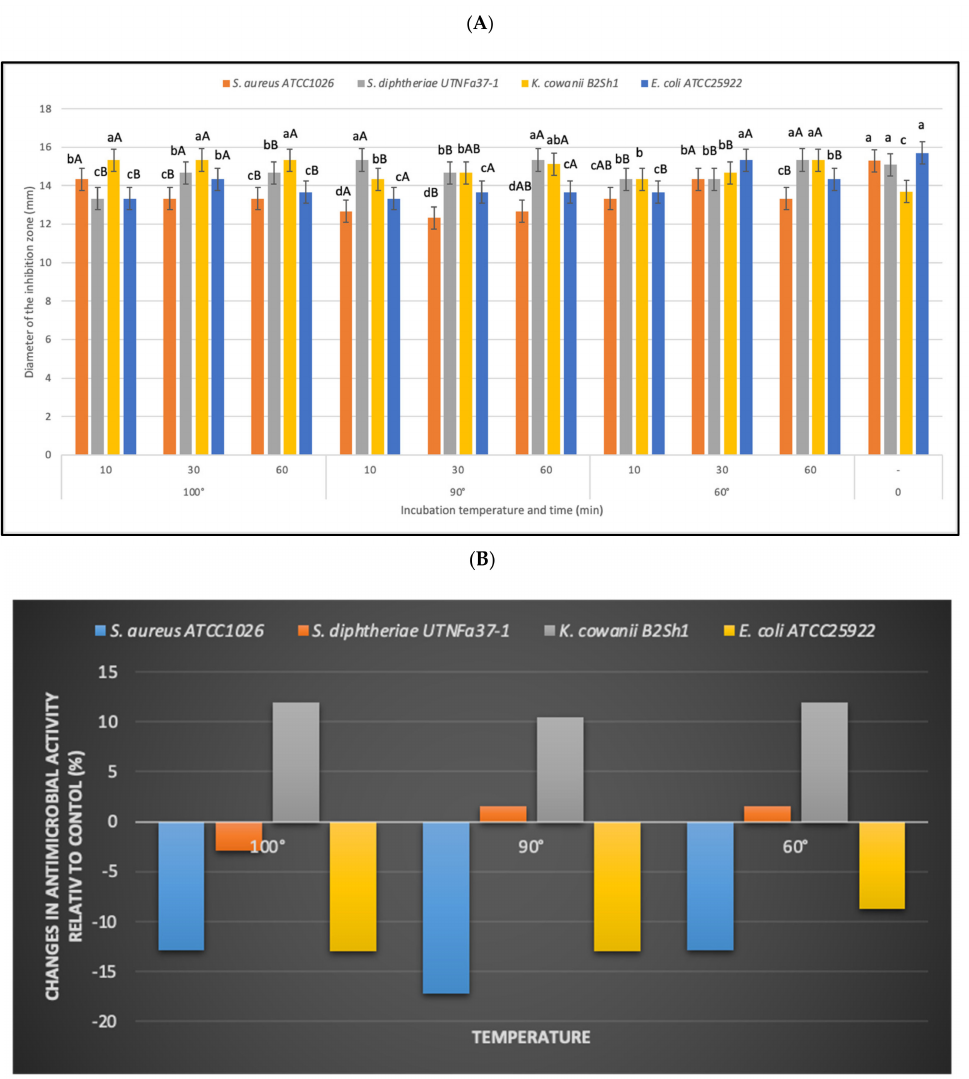
Figure 5. Effect of heat on bacteriocin activity. ( A ) Diameter of the inhibition zone (mm) at different temperatures and incubation time. Bars are the means ± standard error. Values with different